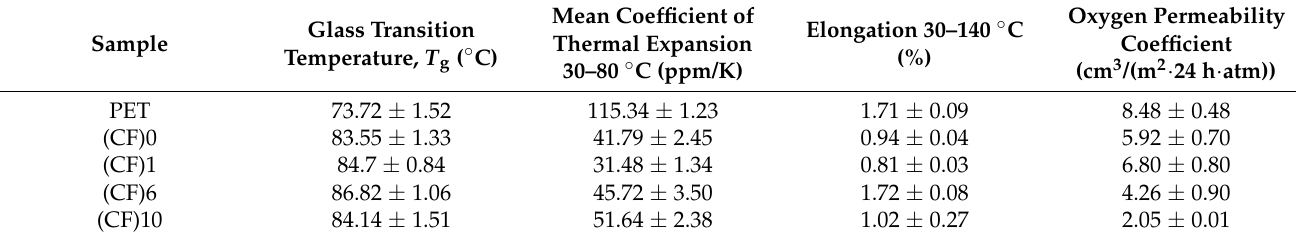
Table 3. Values of glass transition temperature, thermal expansion coefficient, elongation, and oxygen transmission rate for PET foil and PET covered by layers.